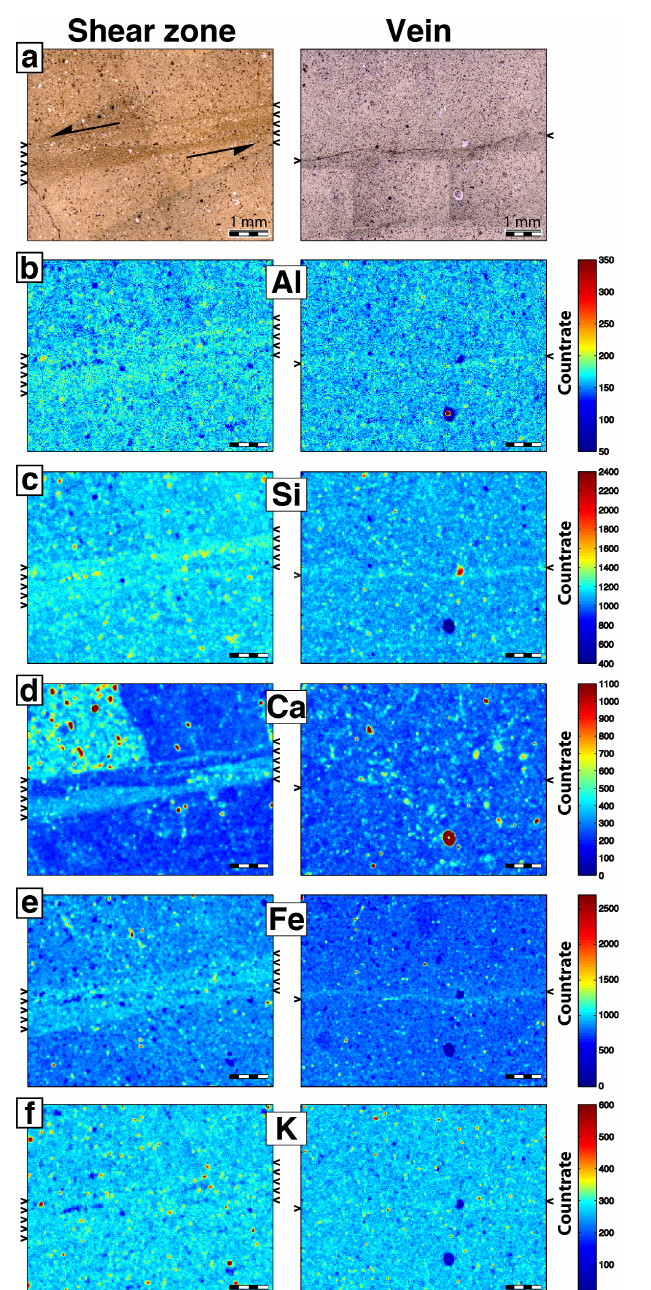
Figure 7. Examples of XRF maps in a shear zone (sample 21R- 2, 82-85) and a vein (10R-2, 2-12). (a) Optical microphotographs (plain light). (b–f) Al, Si, Ca, Fe, and K maps, respectively. Note the enrichment in all the analyzed elements relative to the matrix, except for Ca that is heterogeneously distributed in the shear zone and in the matrix (due to the drag of Ca-rich and Ca-poor beddings) and not enriched in the